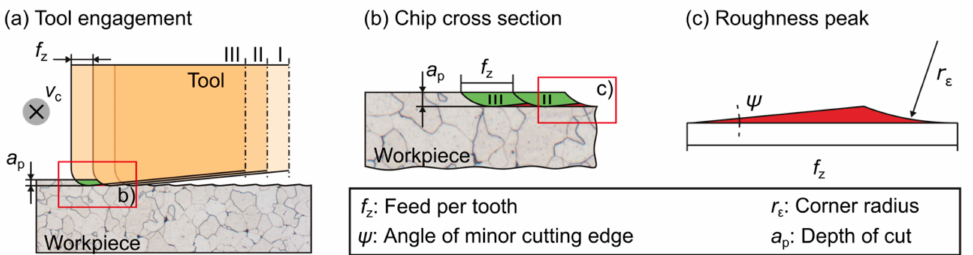
Figure 1. Schematic view of ( a ) a two-dimensional engagement situation during milling, ( b ) two consecutive tooth feeds, ( c ) single milling marks with influencing parameters—as per